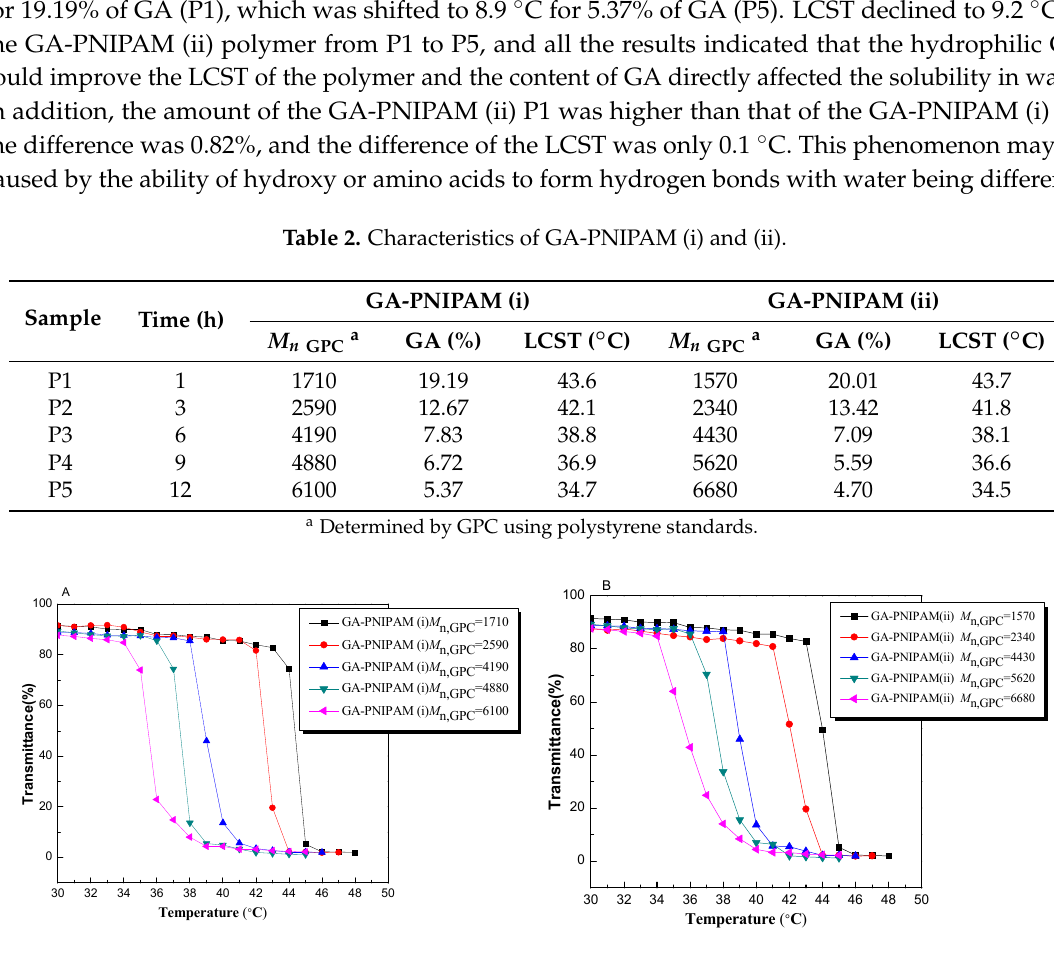
Figure 5. Temperature dependence of optical transmittance at wavelength of 500 nm obtained for aqueous solutions of ( A ) GA-PNIPAM (i) and ( B ) GA-PNIPAM (ii) (1 mg/mL).